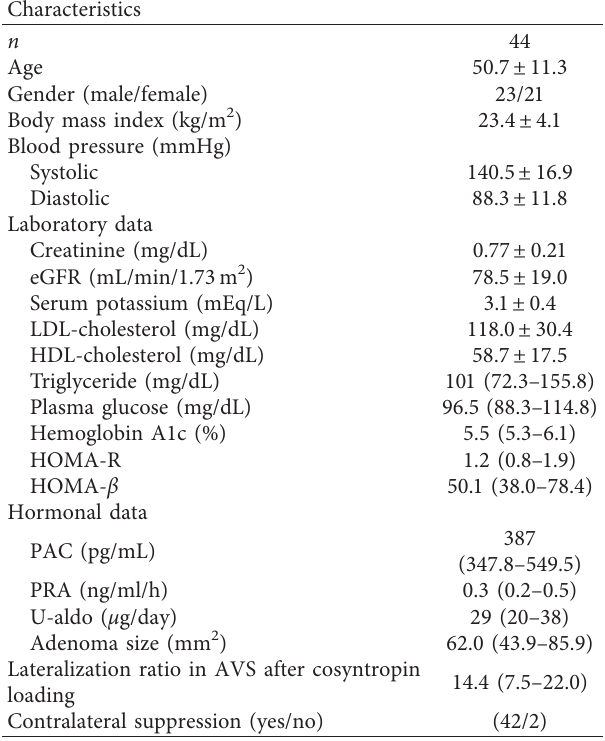
Table 1: Clinical characteristics of pathologically confirmed al- dosterone-producing adenoma group.